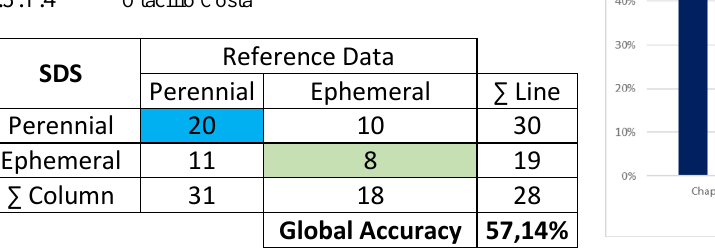
Figure 6 – False Positives per Municipality (in